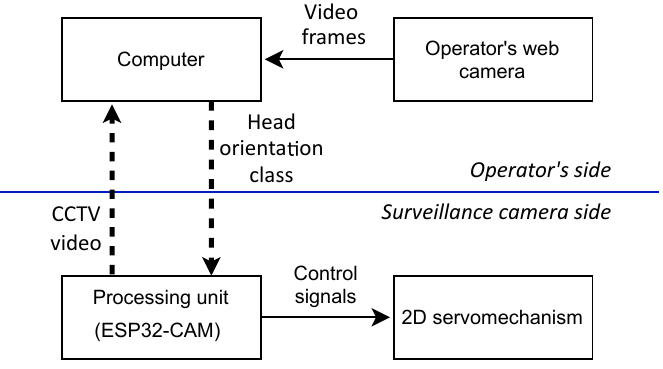
Figure 6. Data flow between the basic components of the proposed system; solid lines represent wire connections, whereas dashed lines denote wireless connections.